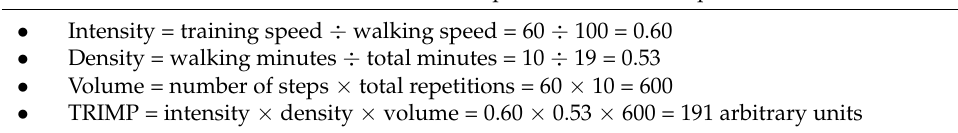
Table 1. Example of the calculation of the TRIMPs. 6MWT Exercise Program Walk 1 min Habitual walking Single training speed recorded session Speed 60